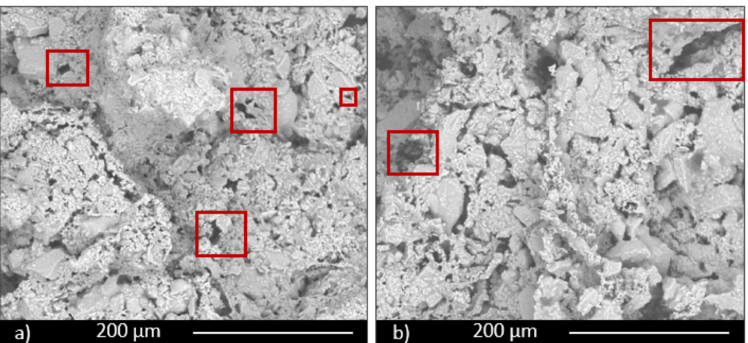
Figure 7. Scaffold (SS FG50) surface ( a ) and section ( b